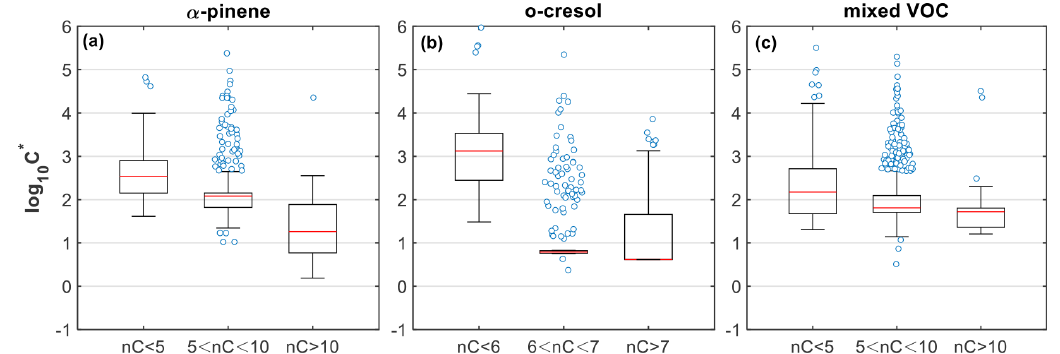
Figure 6. Box plots of the estimated volatility (log 10 C ∗ ) of the products identified in the (a) α -pinene, (b) o -cresol, and (c) mixed VOC experiments (experiment nos. 2, 6, and 10, respectively), weighted to their contributions to the total particle-phase signal and grouped based on their number of carbon atoms. Red lines represent the median values, each boxes’ upper and lower limits represent the 75th and 25th percentiles, respectively, while the error bars represent the minimum and maximum values. The open circles show the individual compounds that were classified as outliers, being outside the interquartile range times